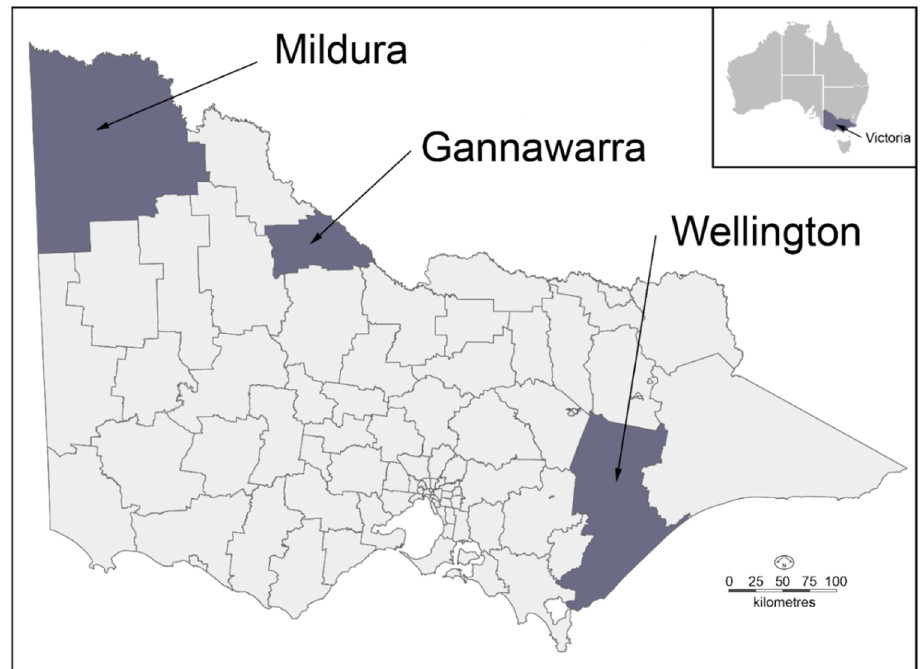
Figure 1. A map of the three locations traps were set up in Victoria, Australia. The highlighted regions represent the local government areas of Mildura, Gannawarra and